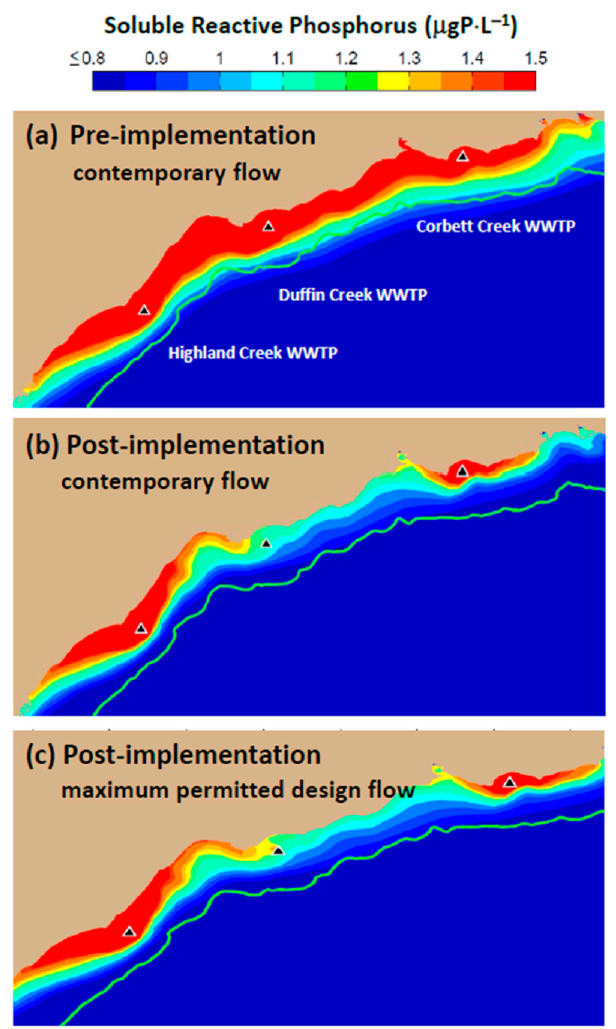
Figure 14. Model-simulated, multiple-source, bottom water SRP footprint for the Pickering–Ajax–Whitby nearshore receiving discharges from the Highland Creek, Duffin Creek and Corbett Creek WWTPs before and after implementation of tertiary treatment at the Duffin Creek WWTP: ( a ) pre-implementation, contemporary flow, ( b ) post-implementation contemporary flow and ( c ) post implementation maximum permitted design